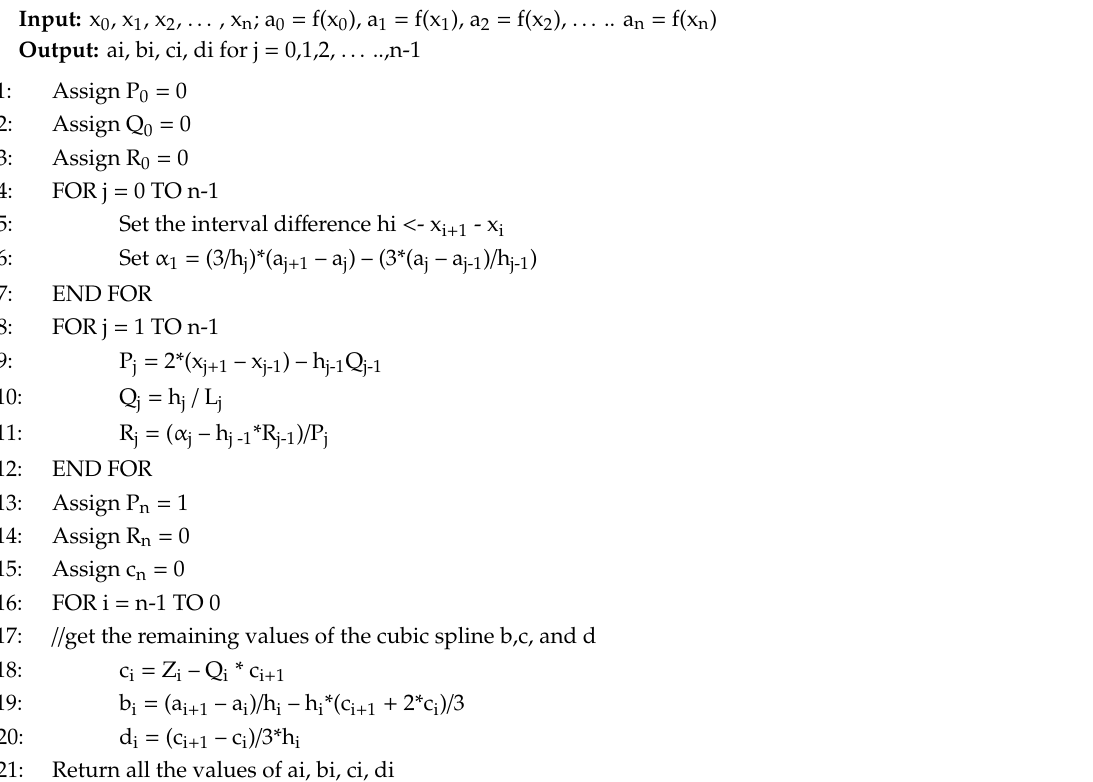
Algorithm 2: Cubic Spline Algorithm to estimate subinterval of UTM waypoints data